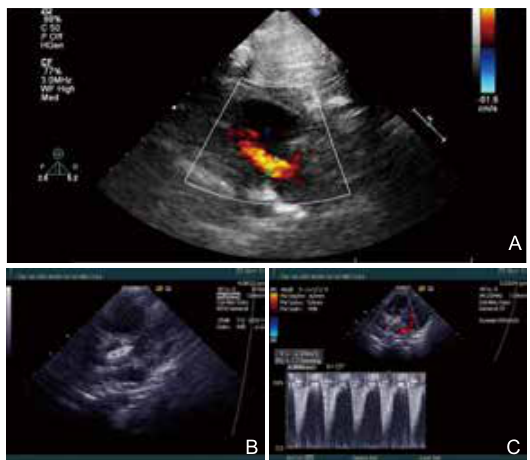
B Figure 1 TTE examination indicated a residual left-to-right shunt (A). The ASO (arrow) was lodged across the aortic valve and was positioned parallel to the direction of blood flow (B). The pulse Doppler imaging showed that the maximum velocity of the aortic valve was 2.09 m/s (C).